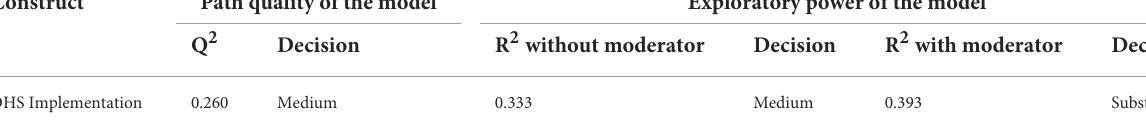
TABLE 4 Structural model: Path quality and exploratory power. Construct